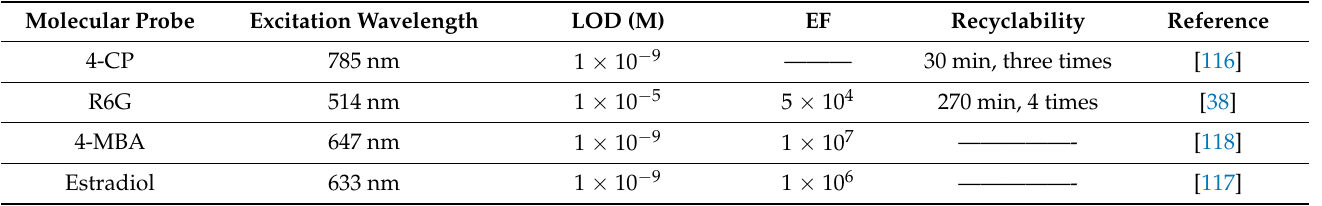
Table 3. Selected examples of SERS performance of Au NPs/TiO 2 substrates as sensors towards some selected molecules. Molecular